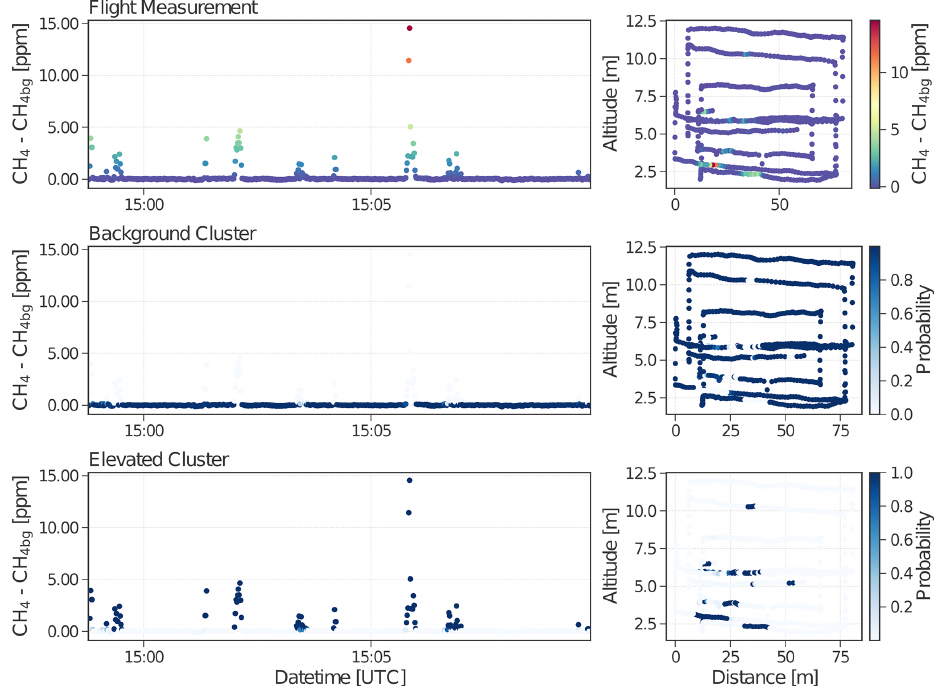
Figure 5. Clustering result for flight 312_03 on 12 March 2020 obtained from the in situ QCLAS after applying a GMM with two mixture components. The background and elevated cluster complement each other; the total probability of each data point shared between the two clusters is equal to